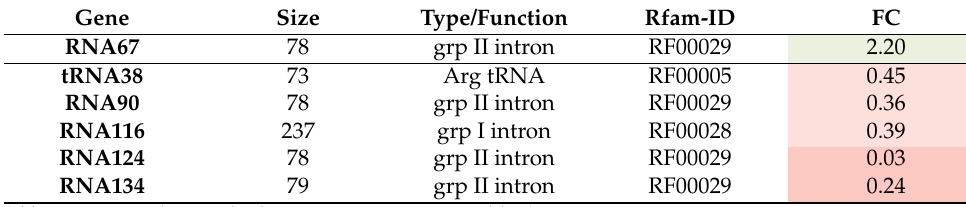
(abbreviations, colors, and selection criteria are as in Table 3). Table 7. Irradiation-induced and repressed RNA genes in P6 but not in